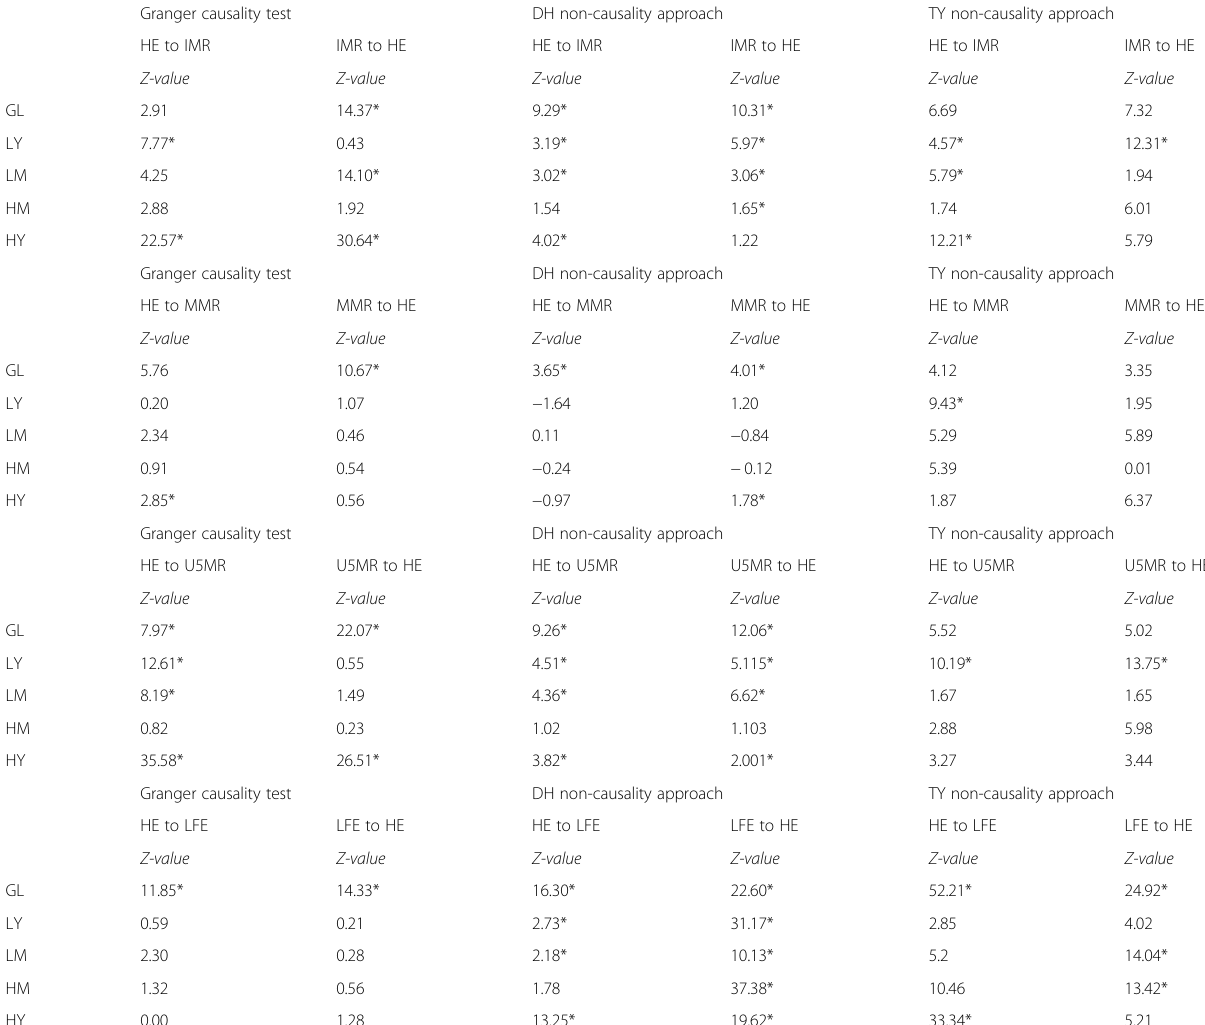
Table 5 Granger causality and non-causality tests Granger causality